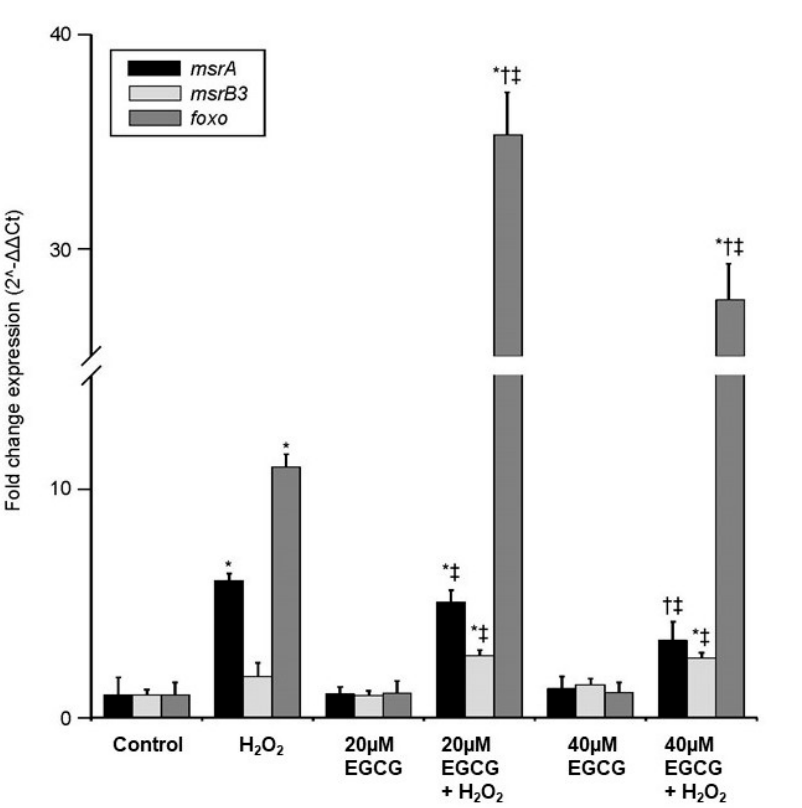
Figure 3. EGCG treatment does not enhance the upregulation of msrA or msrB3 under oxidative stress conditions in whole brain cell cultures. MsrA and foxo3a , but not msrB3 , levels are upregulated by H 2 O 2 treatment, but EGCG treatment alone does not significantly affect msrA , msrB3 or foxo3a expression. While pre-treatment with EGCG enhances the expression of foxo3a beyond stimulation with H 2 O 2 alone, msrA expression in cultures treated with 20 µM and H 2 O 2 is no different than H 2 O 2 alone, while 40 µM EGCG plus H 2 O 2 is slightly but significantly lower. msrB3 expression in cultures treated with either 20 µM or 40 µM EGCG and H 2 O 2 is no different than H 2 O 2 alone. * = significantly different from control, † = significantly different from H 2 O 2 treatment, ‡ = significantly different from same EGCG treatment without H 2 O 2 . ( p < 0.05). Foxo data modified from [58].